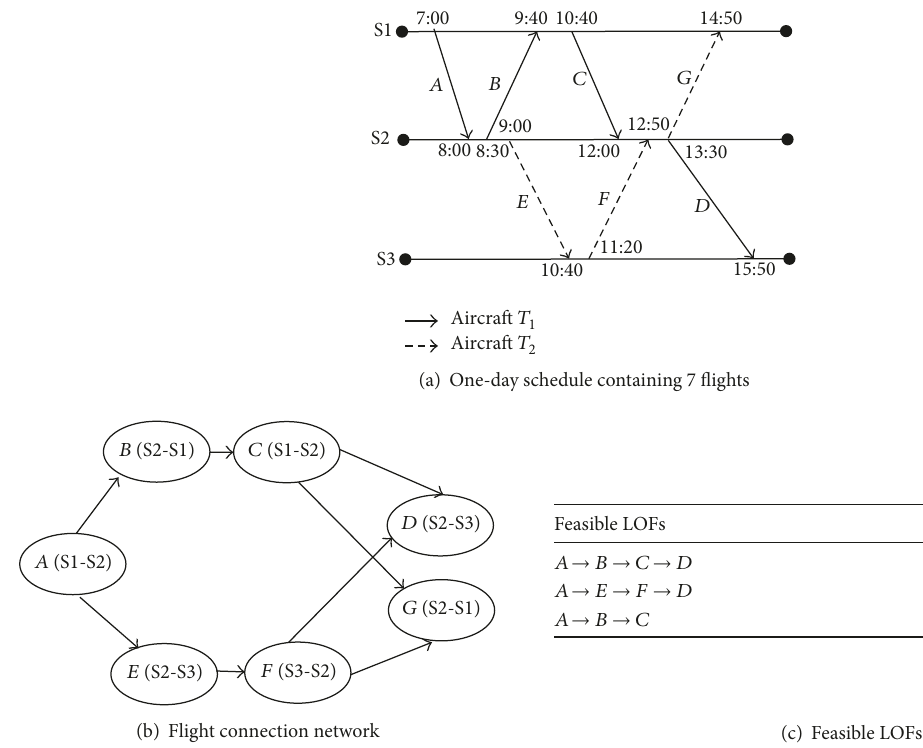
Figure 5: LOF purity: (a) a one-day schedule of two aircraft with seven flights; (b) flight connection network; and (c) feasible LOFs and purity.